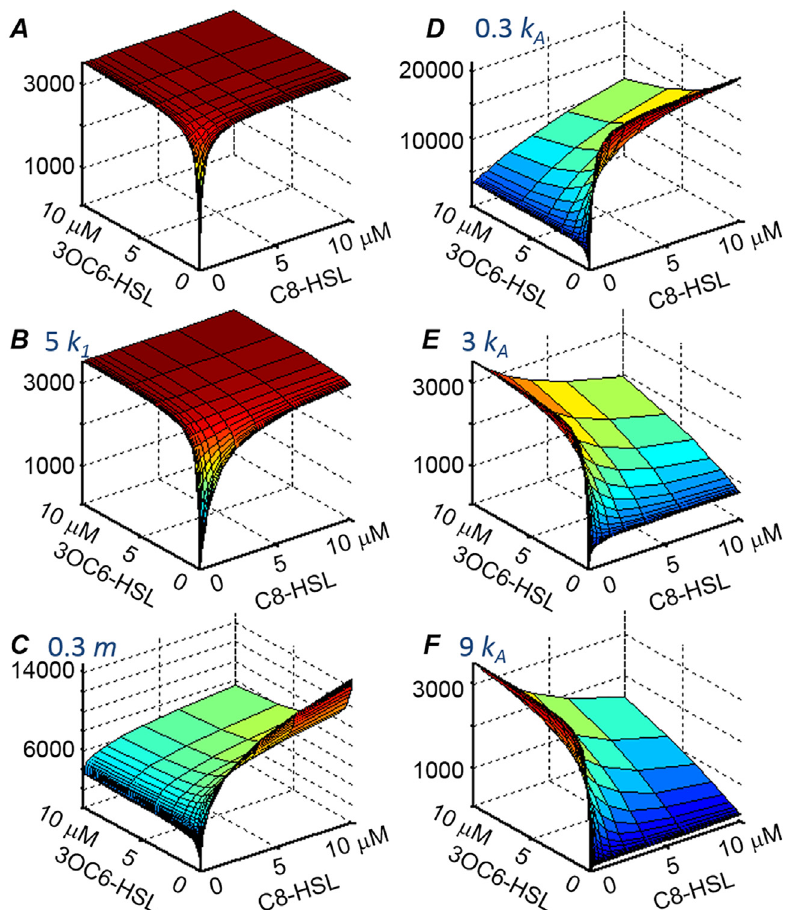
Fig 5. Illustration of the role of the model parameters. In order to show how the predicted HSL response is shaped by the values of the interaction parameters in the model (see Methods ), the predicted response is shown for several different choices of the C8-HSL parameters while the parameters for 3OC6-HSL are held fixed. (Analogous figures are generated if the 3OC6-HSL parameters are varied while the C8-HSL parameters are held fixed). ( A ) Calculated luminescence signal (vertical scale) versus 3OC6-HSL and C8-HSL concentrations (horizontal scales), for parameter values k 1 = 100 nM, k 2 = 100 nM, m = 1, n = 1, k A = 10 nM, k B = 10 nM; ( B ) Calculated response for the same parameter values as in ( A ), except with k 1 increased fivefold to k 1 = 500 nM; ( C ) Response for same parameter values as in ( A ), except with m decreased to 0.3; ( D )-( F ) Response for same parameters as in ( A ), except with k A changed to 3 nM, 30 nM, and 90 nM respectively. In all cases the overall scale parameters (Eq 4) are fixed at a 0 = 10 and a 1 = 550, which were typical for our datasets and